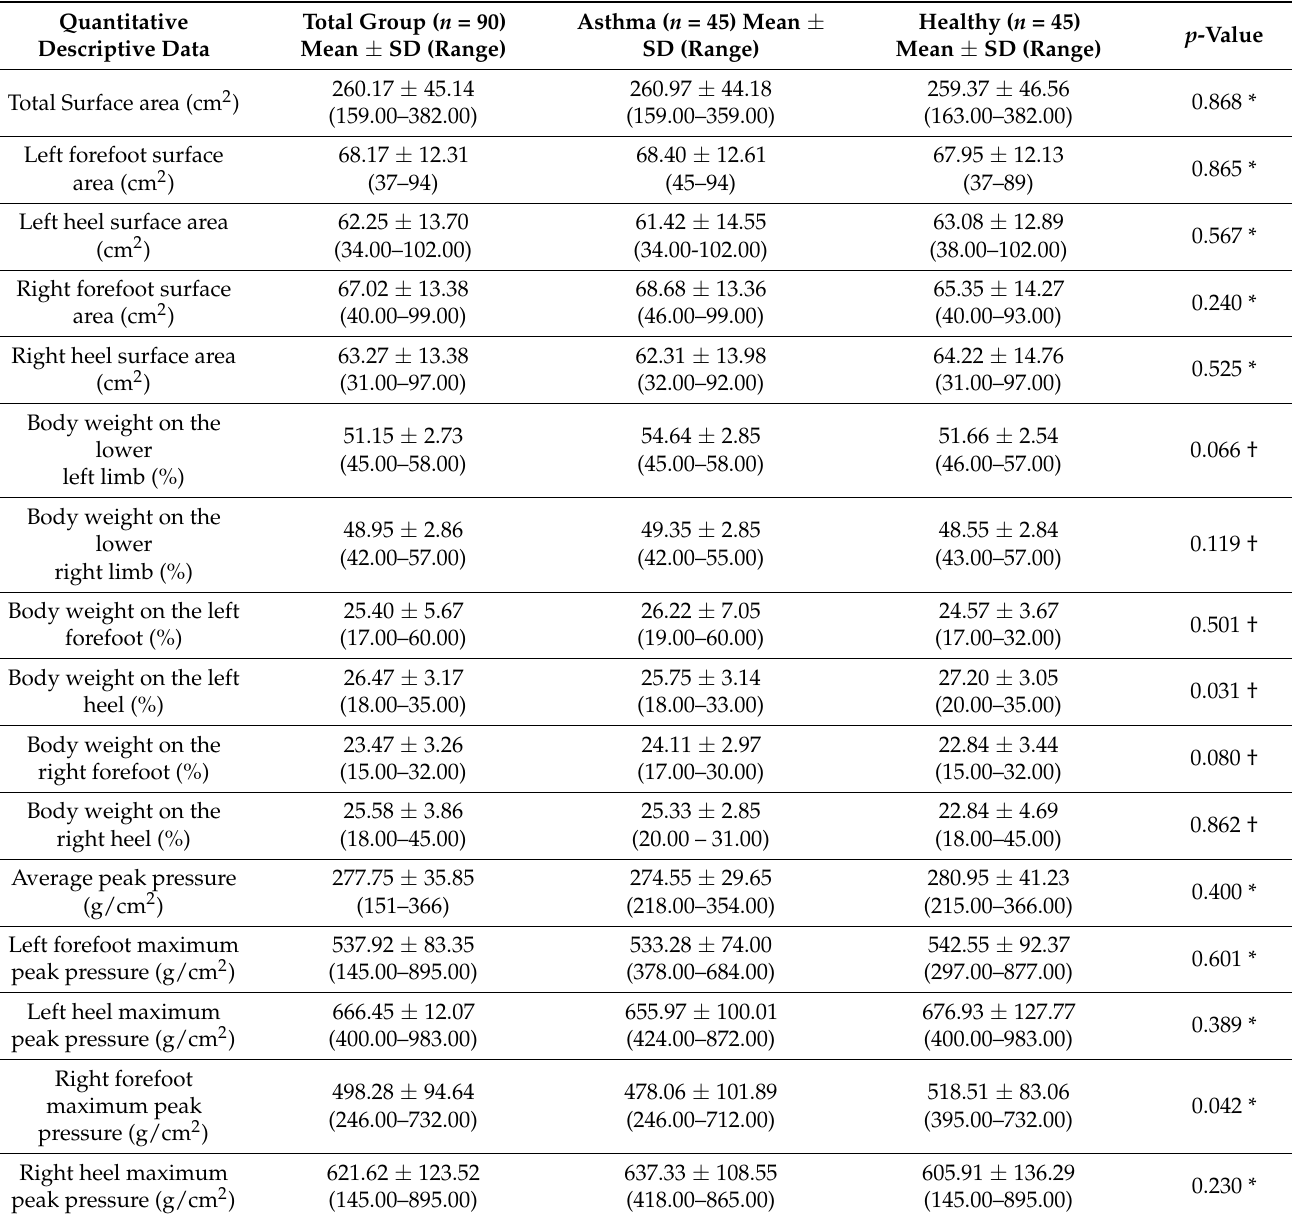
Table 2. Outcome measurements for patients diagnosed with asthma, healthy matched-paired controls and total